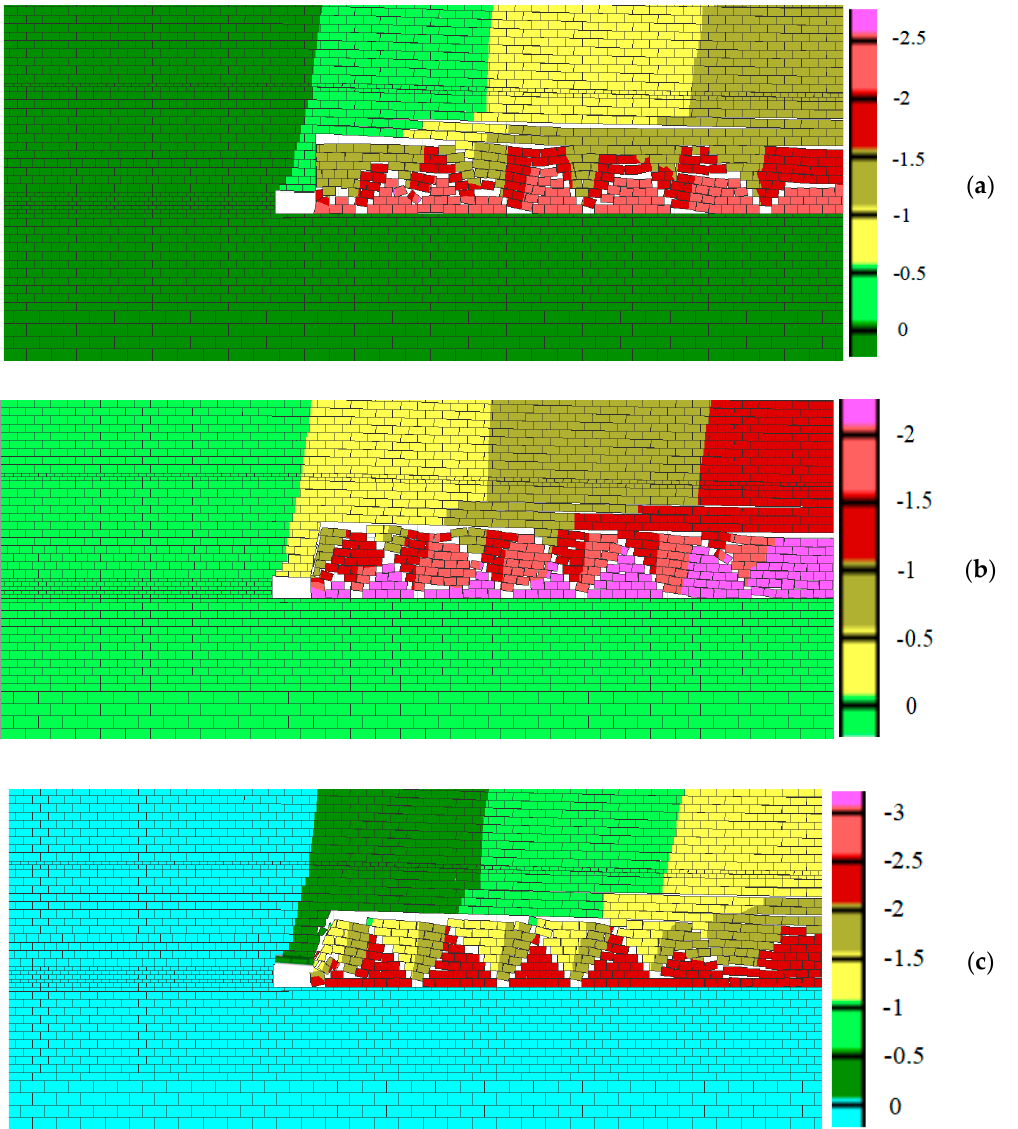
Figure 8. Collapse morphology and vertical displacement model (unit: m). ( a ) Roof cutting angle 0°, ( b ) Roof cutting angle 10°, ( c ) Roof cutting angle 20°.